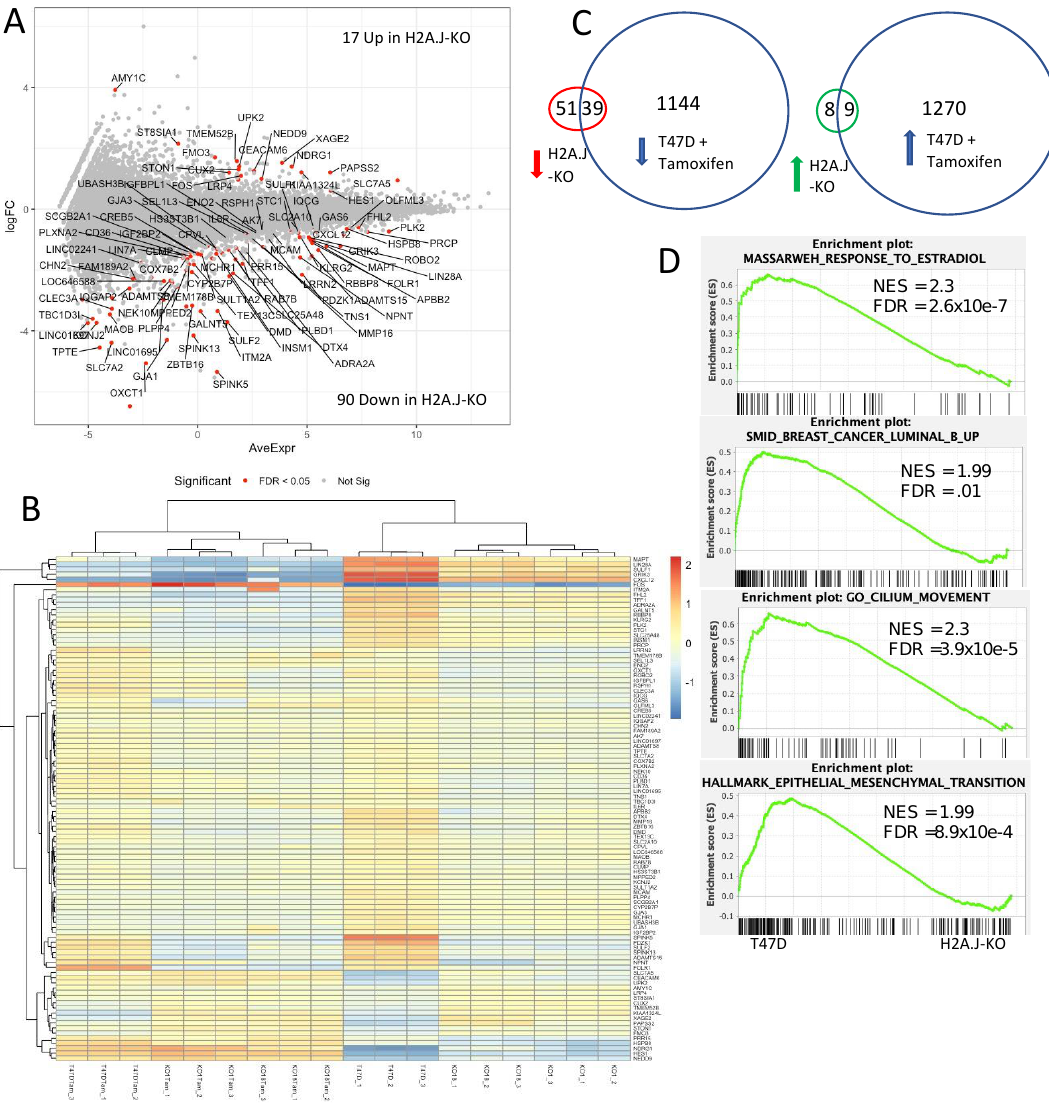
Figure 11. Genes differentially expressed in H2A.-KO cell lines versus parental T47D cells. ( A ) Log2 fold-change (logFC) versus average gene expression for the differentially-expressed genes. The 90 genes down-regulated in H2A.J-KO cells relative to T47D and the 17 genes up-regulated in the H2A.J-KO cells with false-discovery rate (FDR) < 0.05 are indicated in red with their gene names. ( B ) Heat map of the differentially expressed genes for all samples. ( C ) Venn diagrams showing overlaps in gene expression affected by the H2A.J-KO and tamoxifen-treated T47D cells. ( D ) Gene sets in the c2 and Hallmark MsigDB [37] that are enriched with regards to the transcriptome of H2A.J-KO cells compared to parental T47D cells. NES (normalized enrichment score).